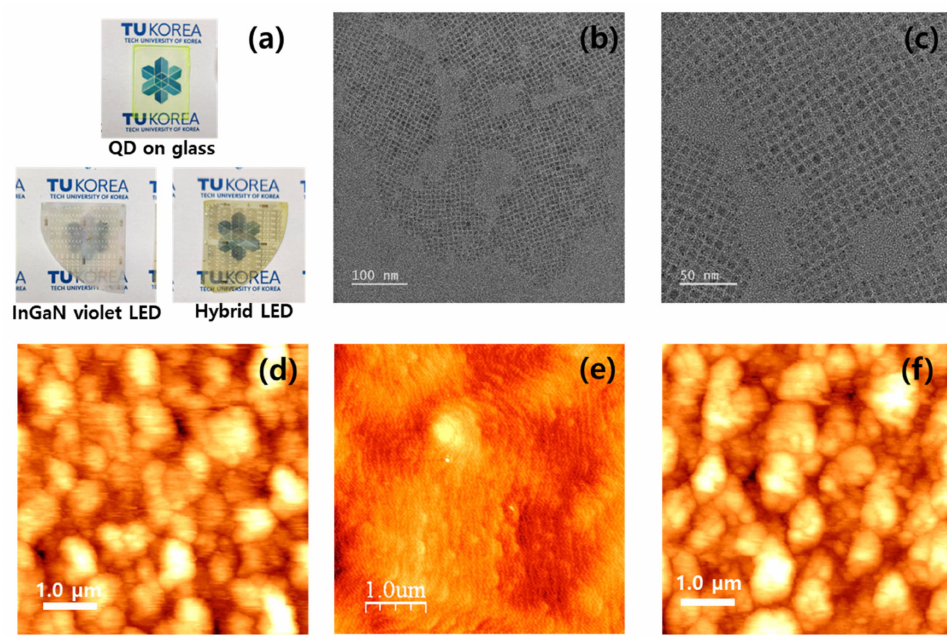
Figure 1. ( a ) Images of spin-coated CsPbBr 3 on glass, conventional InGaN-based violet LEDs, and hybrid LED with CsPbBr 3 QDs. ( b , c ) TEM images of the CsPbBr 3 QDs. Surface morphologies of ( d ) spin-coated CsPbBr 3 on glass, ( e ) InGaN-based violet LED, and ( f ) hybrid LED with CsPbBr 3 QDs obtained by